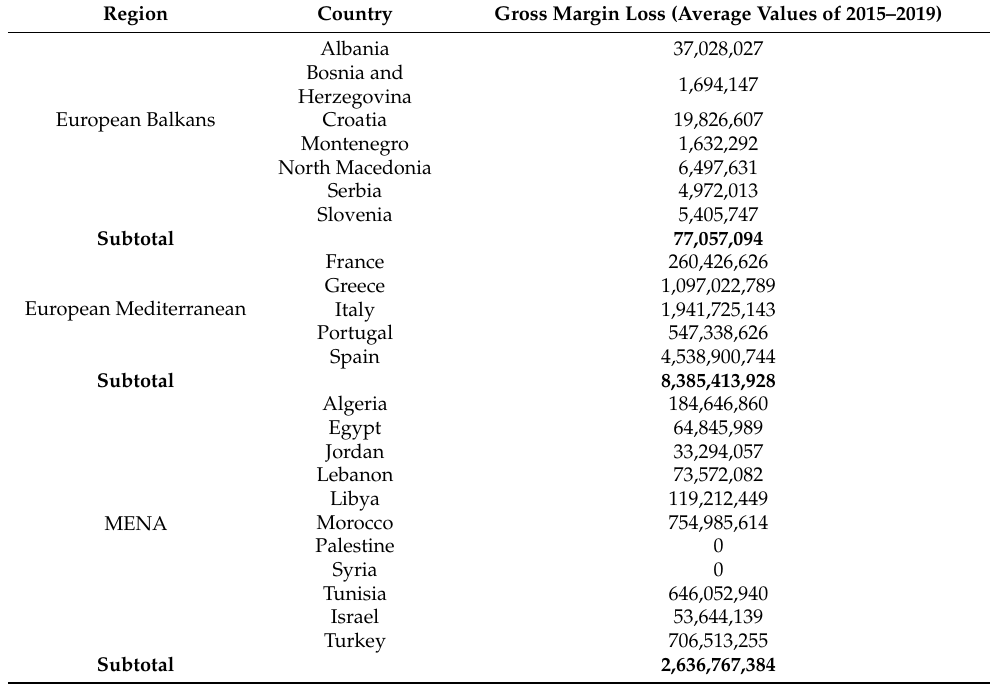
Table 3. Economic impacts of Xylella fastidiosa in terms of gross margin on olives, grapes, Citrus spp., and almonds in the Mediterranean basin. Region